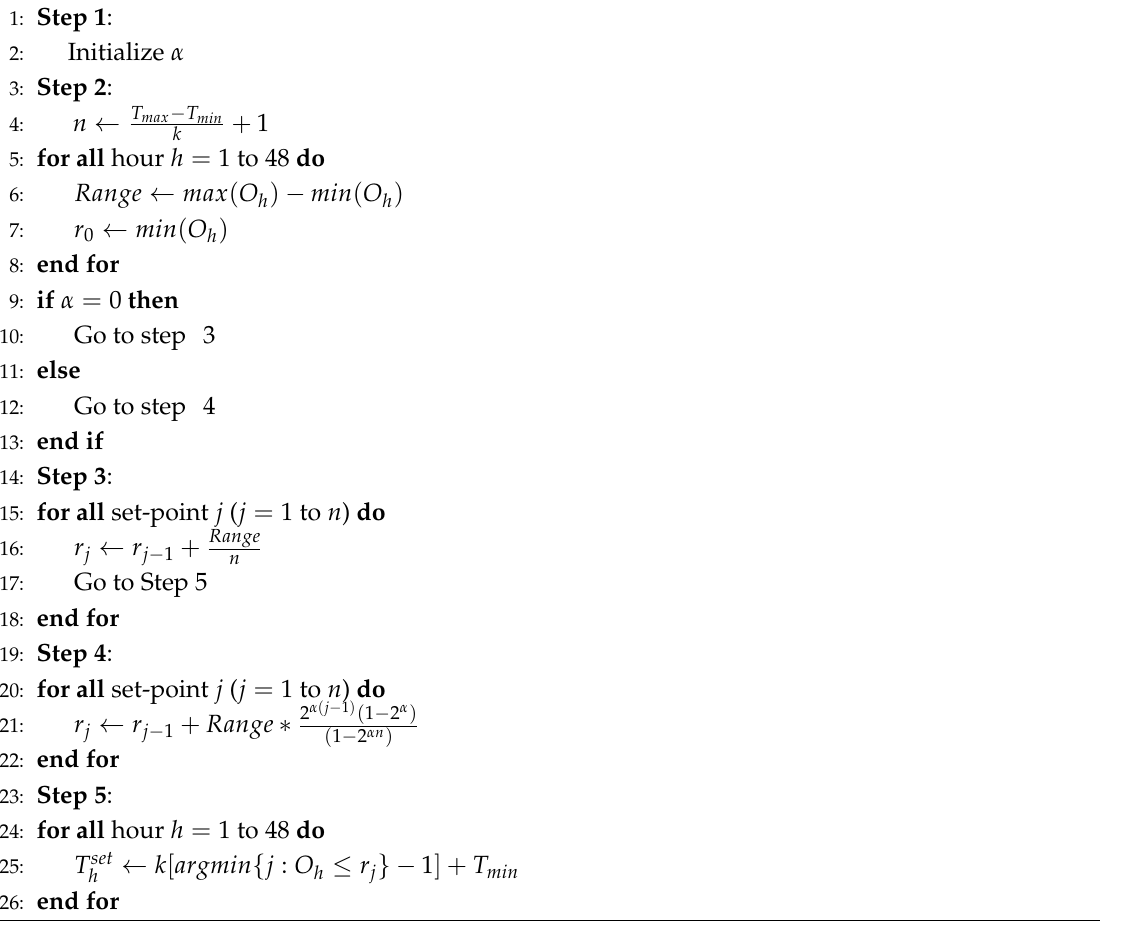
Algorithm 1 Temperature Setting Algorithm